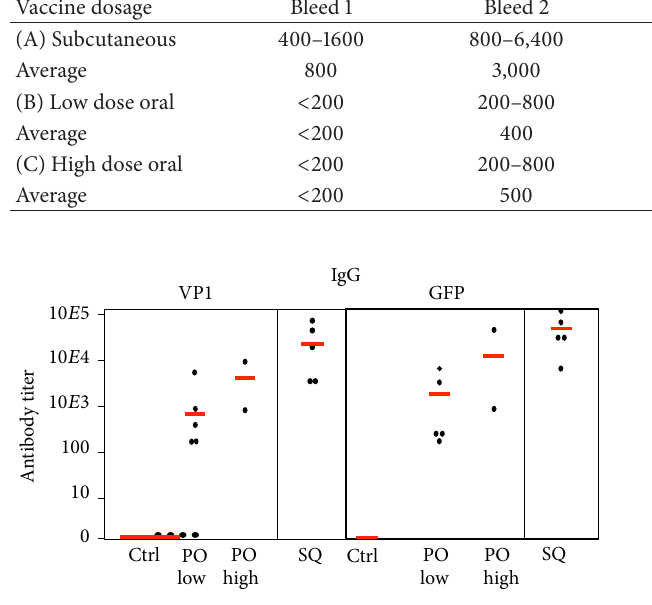
Figure 13: VP1-specific (left) and GFP-specific (right) IgG titers (ELISA) in sera from bleed 5 in mice vaccinated with VP1-GFP YCPs. Vaccine was administered orally (PO) at lower (3x 400 𝜇 g VP1-GFP) and higher (3x 960 𝜇 g VP1-GFP) doses or subcutaneously (SQ) at a 96 𝜇 g dose. Control (Ctrl) mice were not vaccinated. Red lines indicate mean values.